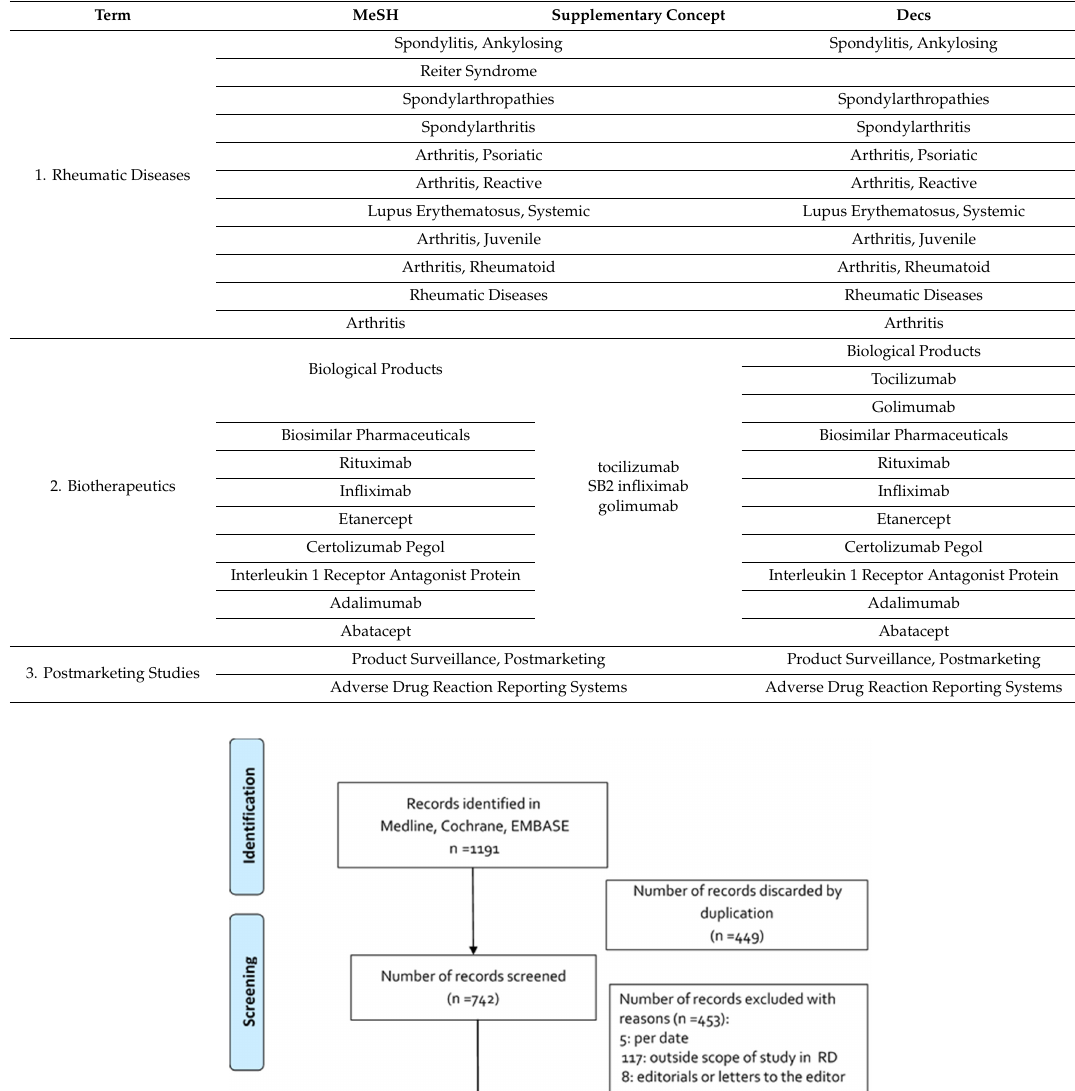
Table 1. MeSH and Decs used in electronic database.